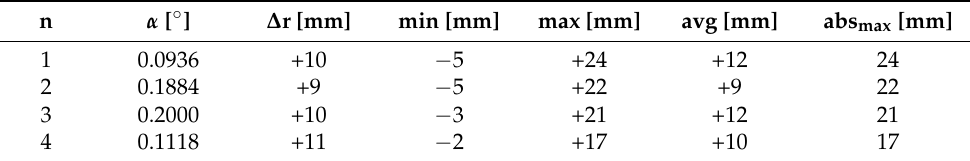
Table 5. Differences between the as-planned and the as-built model—cylindrical